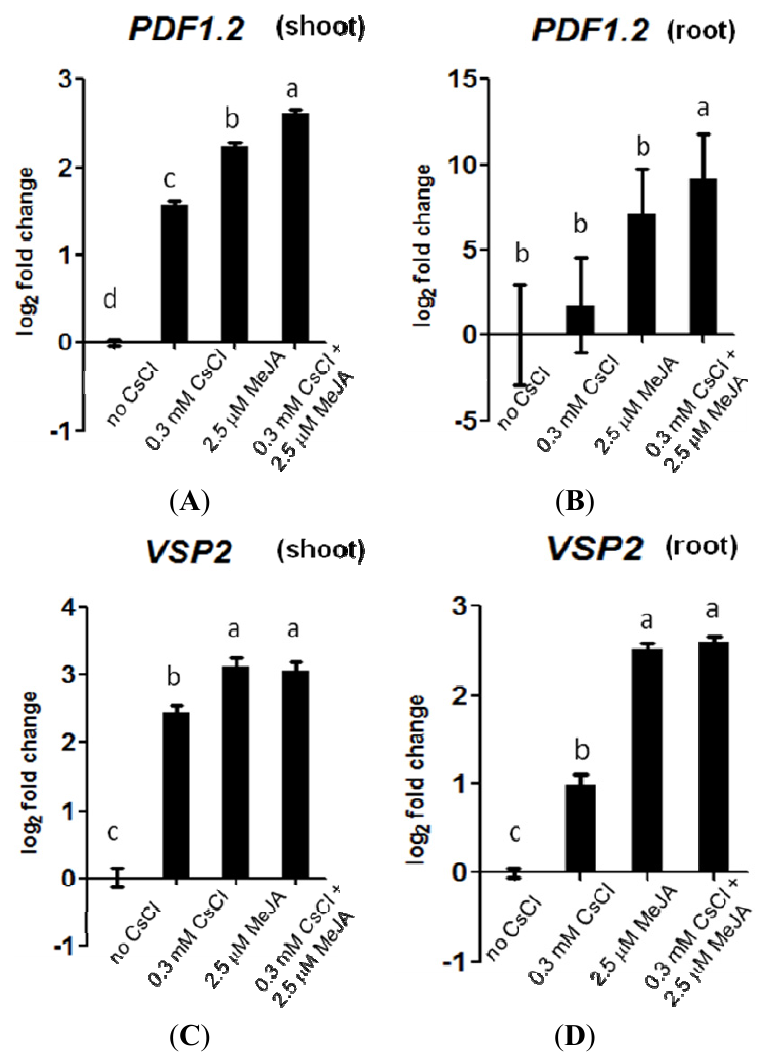
Figure 3. ( A ) Gene expression of PDF1.2 in Col-0 shoots and ( B ) roots, and ( C ) gene expression of VSP2 in Col-0 shoots and ( D ) roots, grown on 1.75 mM KCl with or without 0.3 mM CsCl and 2.5 mM methyl jasmonate (MeJA) for 11 days. Values are log relative to the control. Error bars indicate standard error for three technical replicates. Each sample contained more than 15 seedlings, and the experiment was repeated three times, one of which is presented. Alphabetical letters show statistical differences ( p <